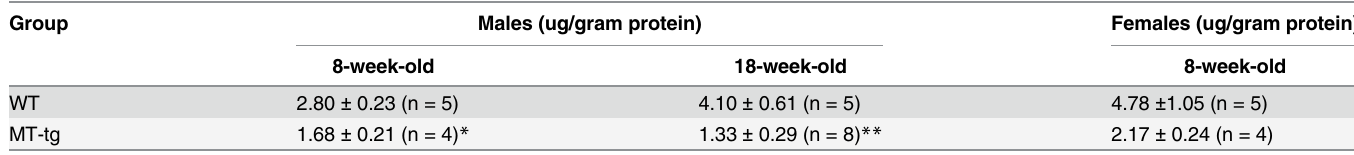
Note: Values are expressed as the mean ± SEM. n values represent the number of mice. 18-week-old female pancreas was not prepared. * p <